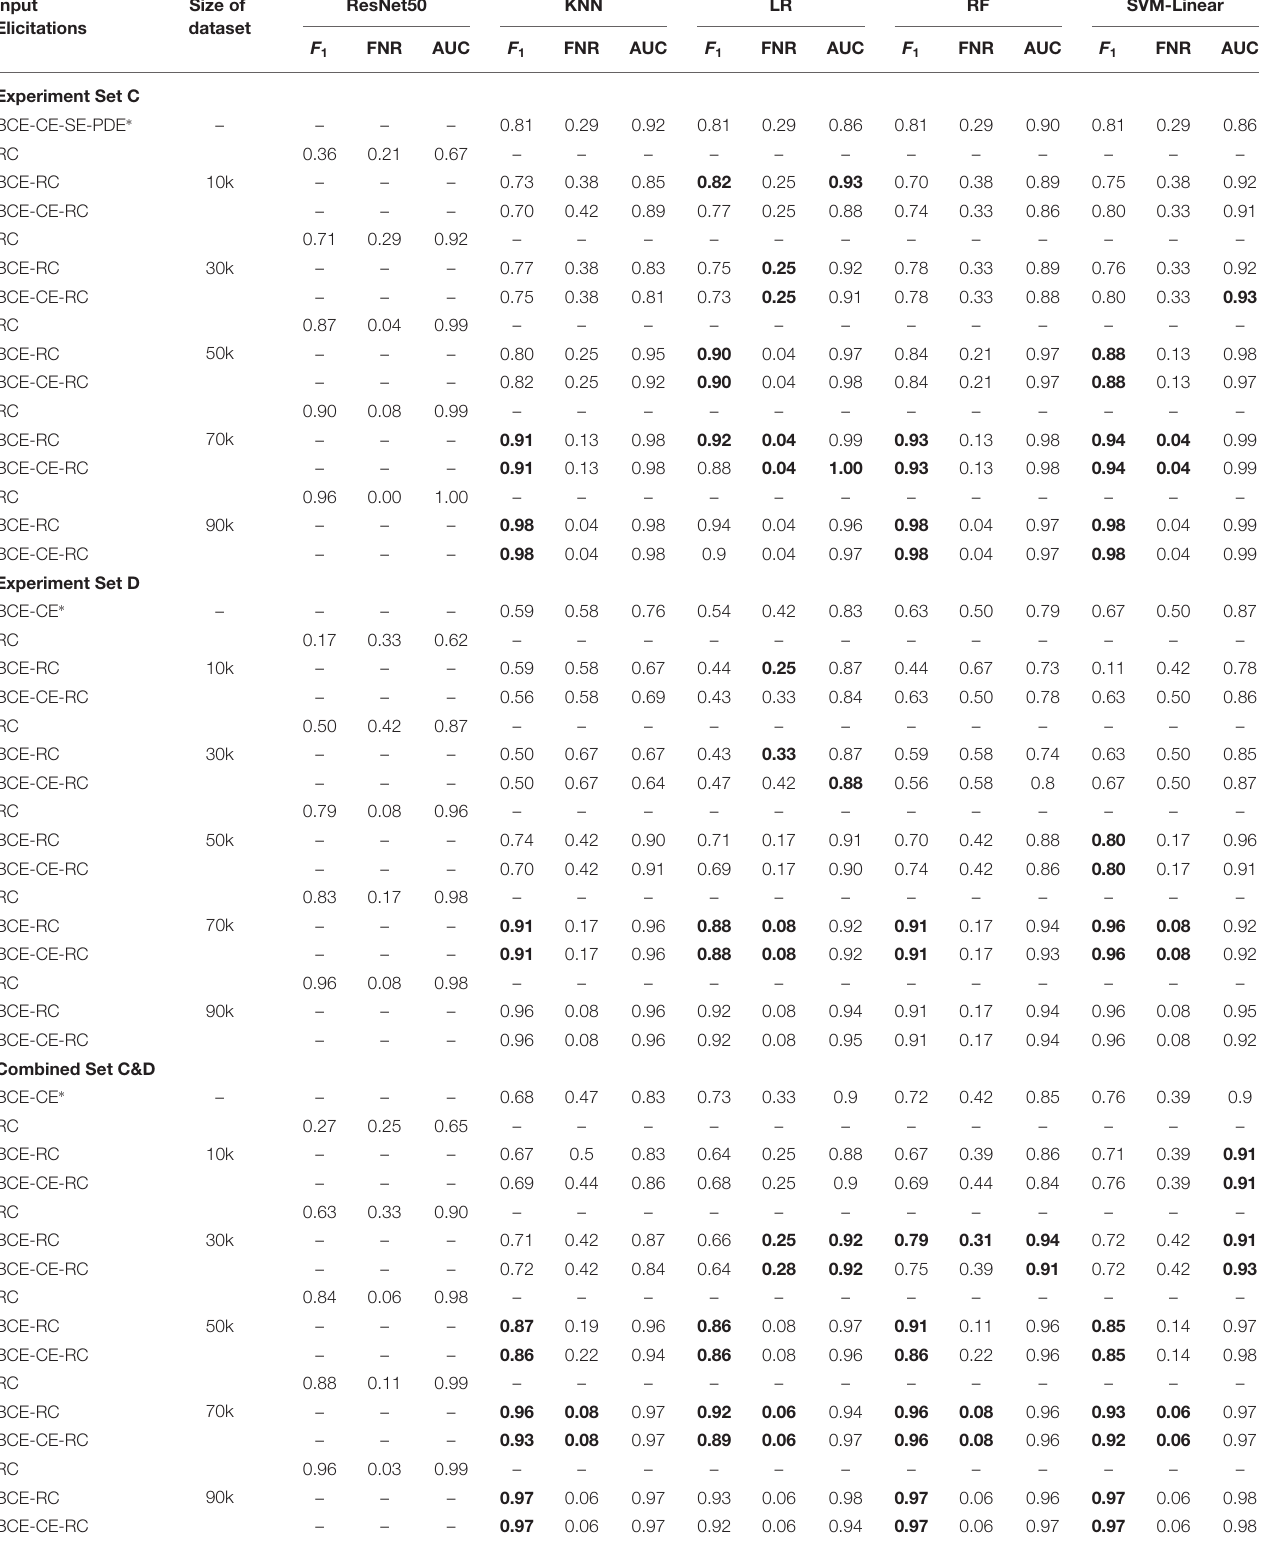
TABLE 6 | Performance analysis of Crowdsourcing-based ML methods with expanded inputs from ResNet-50. Input